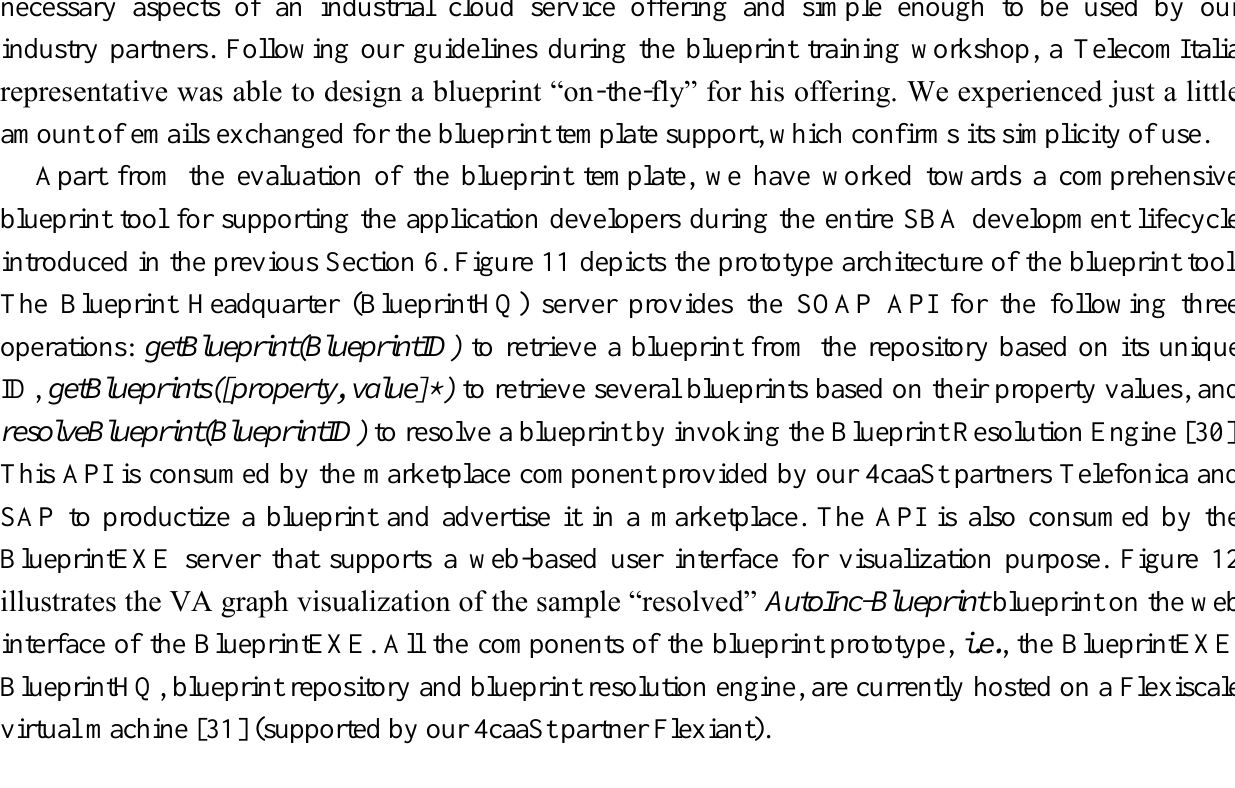
Figure 10. XML implementation of the sample AutoInc-Blueprint